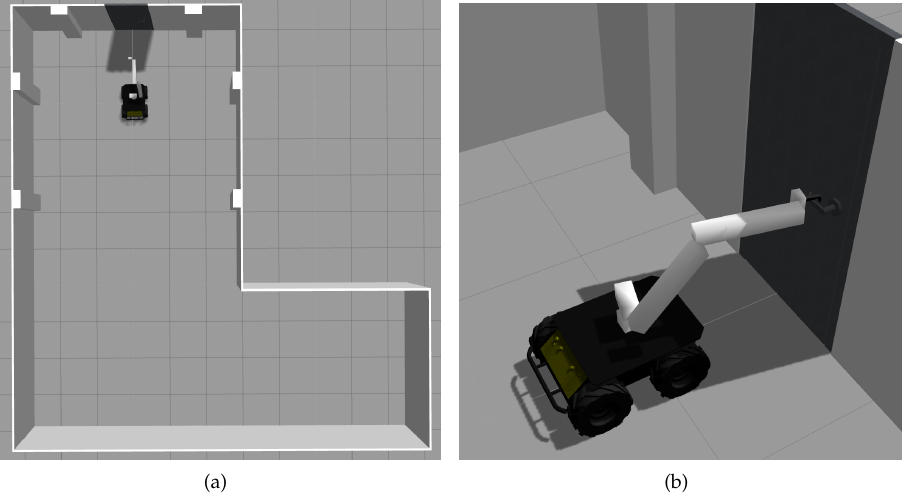
Figure 20. ( a ) Top view of the simulated environment. ( b ) Robotic platform interacting with the door